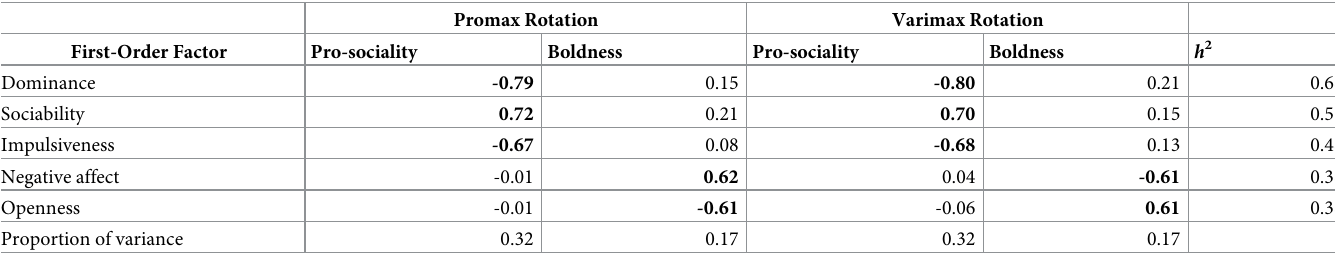
Table 4. Pattern matrix from the second-order factor analysis of personality